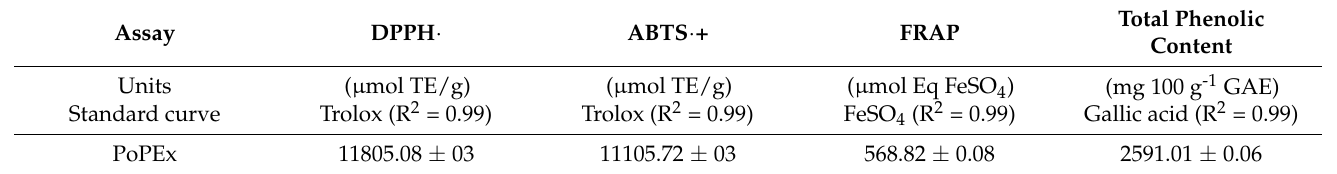
Table 3. Antioxidant activity and total phenolic content of